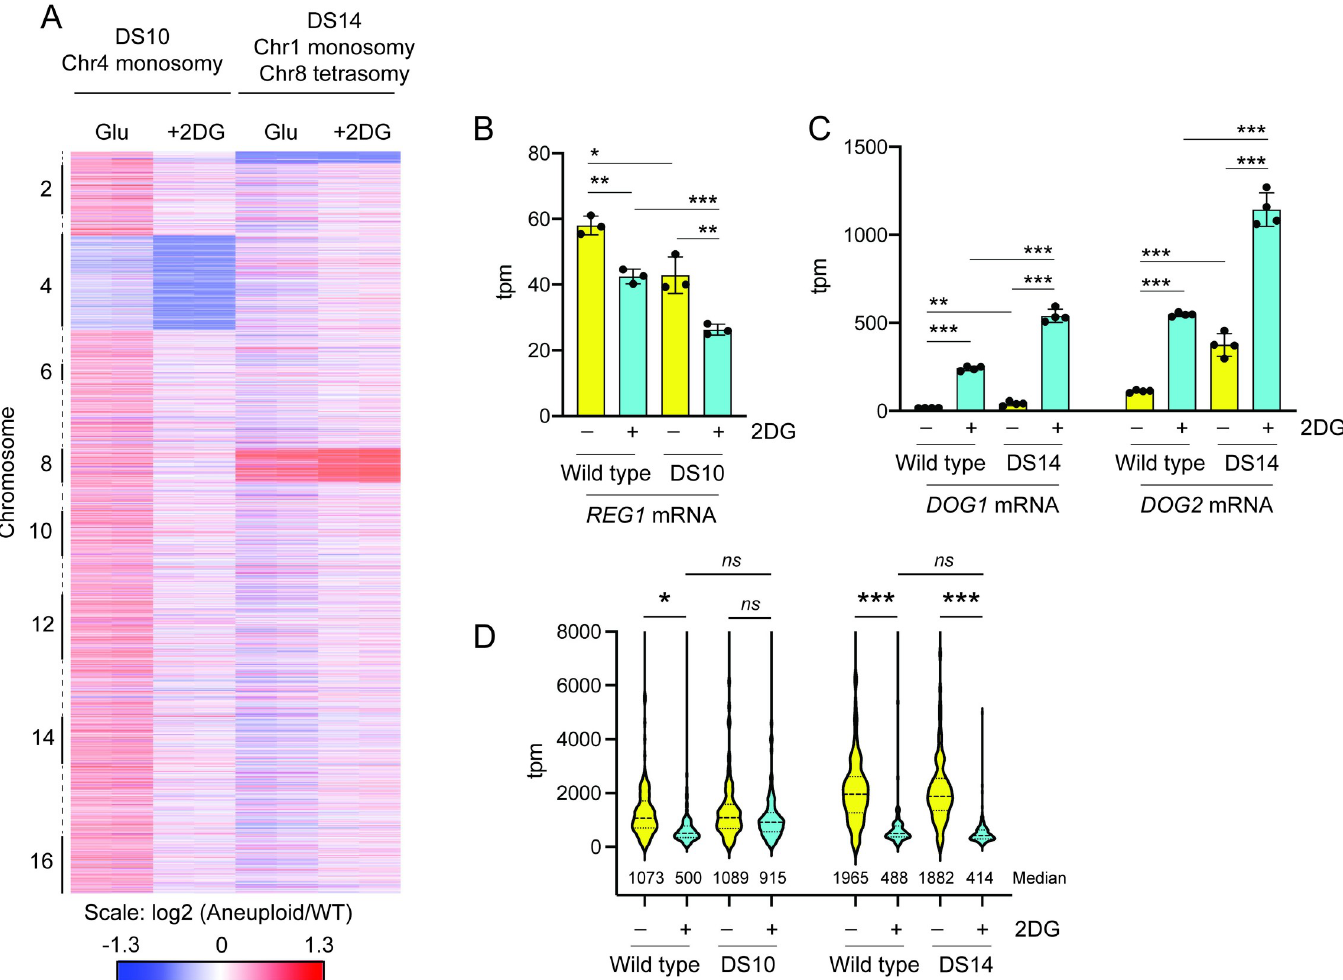
Fig 7. Effect of Aneuploidy on mRNA expression. A. Analysis of mRNA abundance was performed using RNAseq in wild type and DS10 cells washed off agar plates and grown for 2 hours in SC media with 2% glucose with and without 2DG. The log2 ratio of mRNA abundance from aneuploid strain divided by the wild type abundance is shown. Genes on the vertical axis are clustered by chromosome. The same RNAseq analysis was also performed on wild type and DS14 cells grown to mid-log in SC media and two hours after addition of 2DG. Two biological replicates for each strain and condition are shown. B. REG1 mRNA abundance as transcripts per million mapped reads (tpm) is shown for wild type and DS10 cells with and without addition of 2DG. C. DOG1 and DOG2 mRNA abundance is shown for wild type and DS14 cells with and without addition of 2DG. D. Ribosomal protein mRNA levels for wild type and aneuploid strains with and without 2DG treatment. TPM Values for 132 mRNAs are shown in a violin plot with the median value indicated